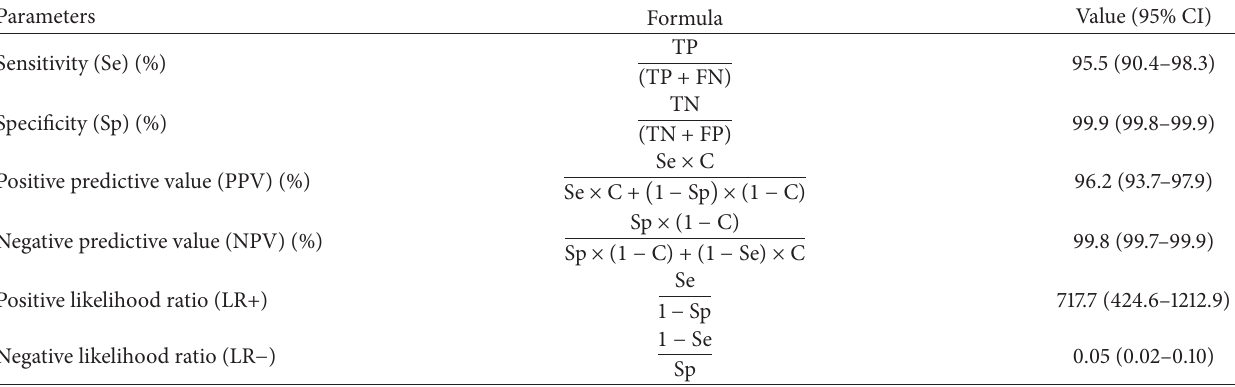
Table 2: Sensitivity, specificity, predictive values and likelihood ratios.